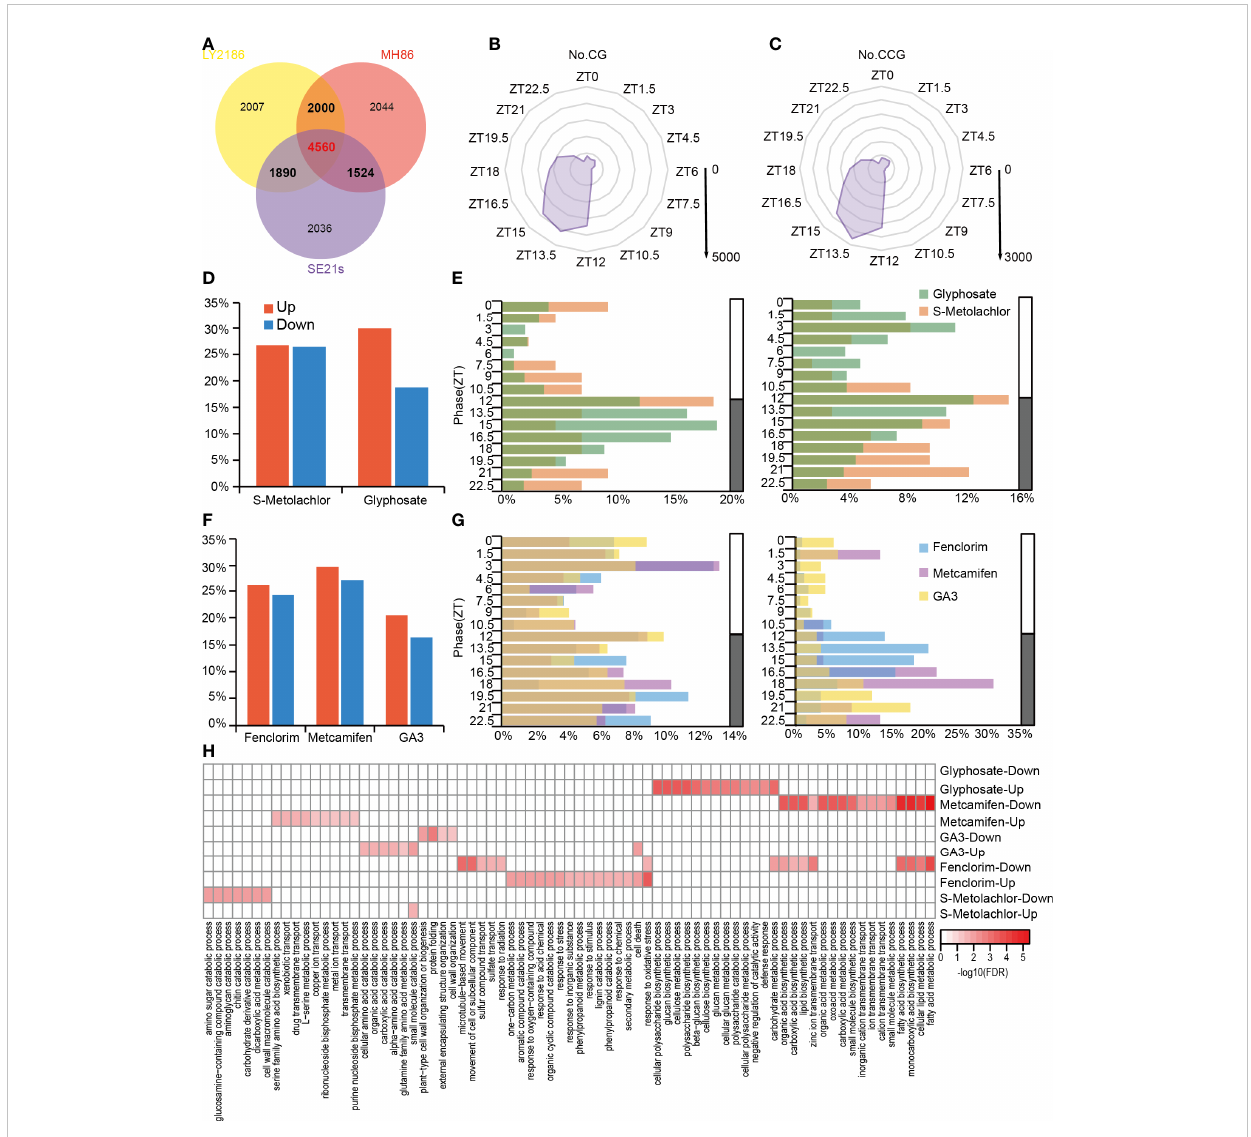
FIGURE 3 The crosstalk of rice circadian rhythm and herbicide response processes at transcriptome level. (A) Venn diagram indicating CGs, CCGs and speci fi c genes is shown. Genes with a 24-hour stable circadian rhythm in at least two rice varieties are de fi ned as CG (indicated by bold font); genes with a 24-hour stable circadian rhythm in all three rice varieties are de fi ned as CCG (indicated by red bold font). (B) Phase distribution of the CGs. The coordinates of each angle represent phases ZT0 – ZT24. The inner to outer circles represent 1,000-5,000 genes reaching peak expression at that time point, respectively. (C) Phase distribution of the CCGs. The coordinates of each angle represent phases ZT0 – ZT24. The inner to outer circles represent 500-3,000 genes reaching peak expression at that time point, respectively. (D) The percentage of rhythmic herbicide-responsive genes in the total herbicide-responsive genes. (E) Phase distribution of rhythmic herbicide-responsive genes. The left panel is rhythmic herbicide-induced genes and right panel is rhythmic herbicide-suppressed genes. (F) The percentage of rhythmic herbicide safener-responsive genes in the total herbicide safener-responsive genes. (G) Phase distribution of rhythmic herbicide safener-responsive genes. Left panel is rhythmic herbicide safener- induced genes and the right panel is rhythmic herbicide safener-suppressed genes. (H) Heatmap of GO enrichment analysis of rhythmic herbicide- responsive